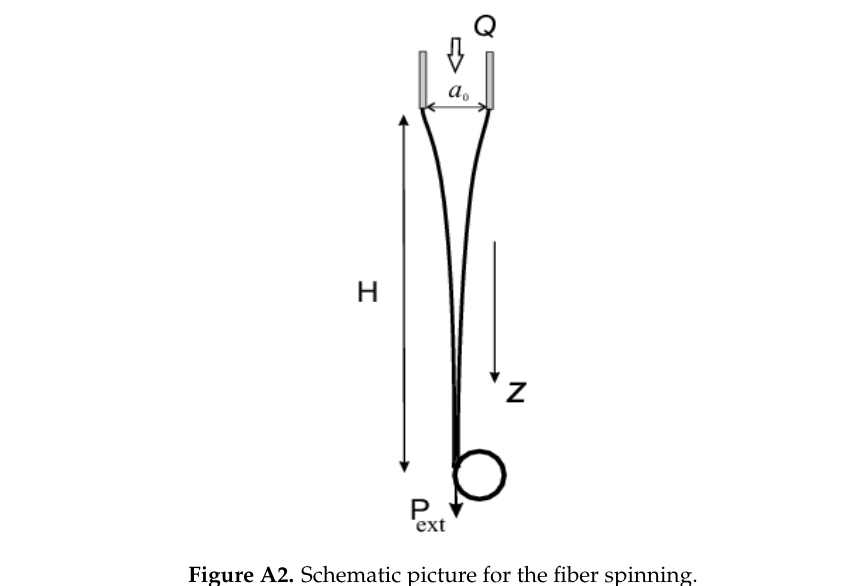
P applied on a distance H from the die (Figure A2). ext